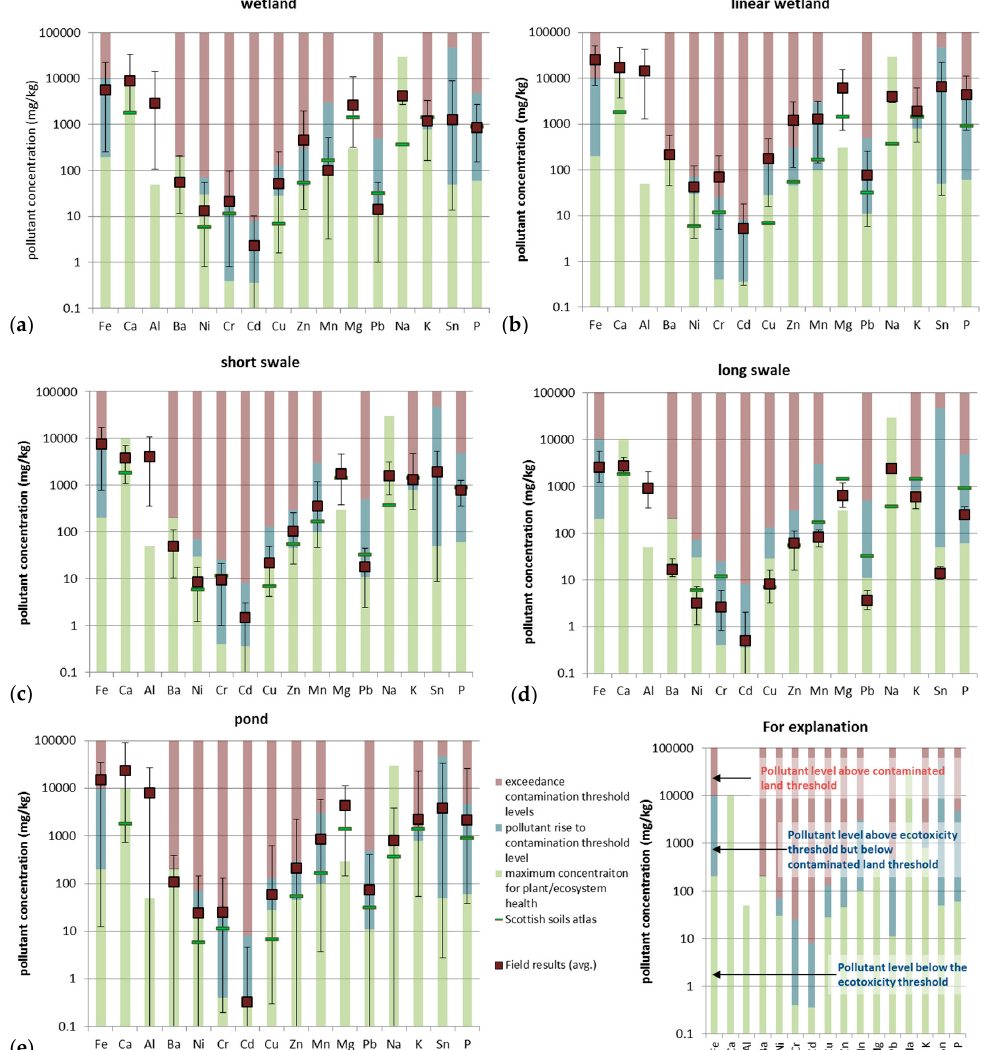
Figure 1. A comparison of deposited sediment contaminant concentrations for the wetland ( a ), linear wetland ( b ), short swale ( c ), long swale ( d ) and pond ( e ). Red bars indicated the exceedance of contaminated land thresholds and have no upper limit , blue bars indicate exceedance of ecotoxicity levels and green bars indicate sediment contaminant levels below ecotoxicity thresholds. Where no contaminated land thresholds are presented in guidance documents, the blue and red bars are vacant from the graphs. Field data falling within the red bars indicate exceedance of contaminated land threshold trigger and therefore may be of concern.